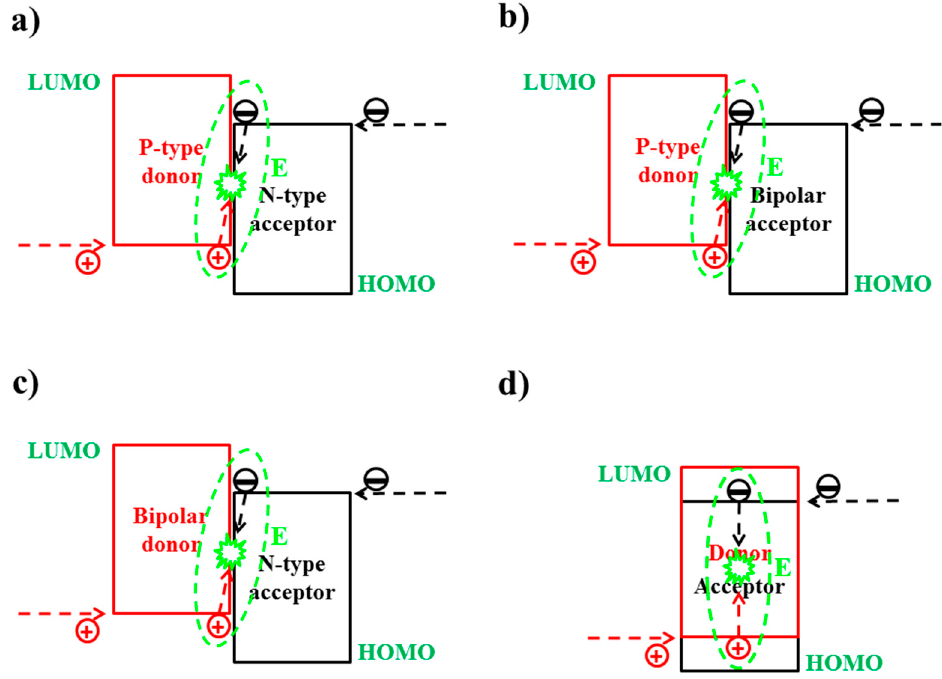
Figure 1. The diagram of formation exciplex or electroplex at the bilayer interface of p-type donor material and n-type acceptor material ( a ), p-type donor material and bipolar acceptor material ( b ), bipolar donor material and n-type acceptor material ( c ), co-doping donor and acceptor materials ( d ). E represents exciplex or electroplex, the black arrow and red arrow are electron and hole transporting, respectively.